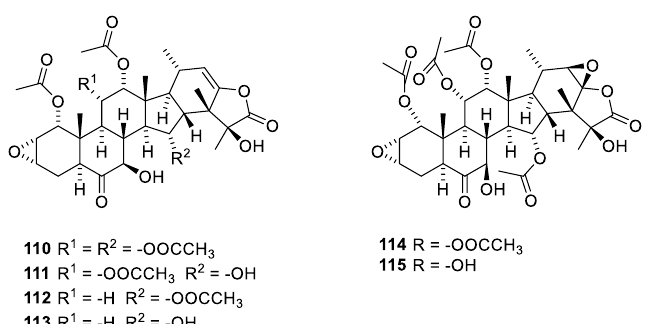
Figure 30. The taccanlonolides. Taccalonolides A ( 110 ) and E ( 112 ) were isolated from tubules of Tacca chantrieri. Taccalonolides B ( 111 ) and N ( 113 ) are semisynthetic analogues. Taccalonolides AF ( 114 ) and AJ ( 115 ) [103] .